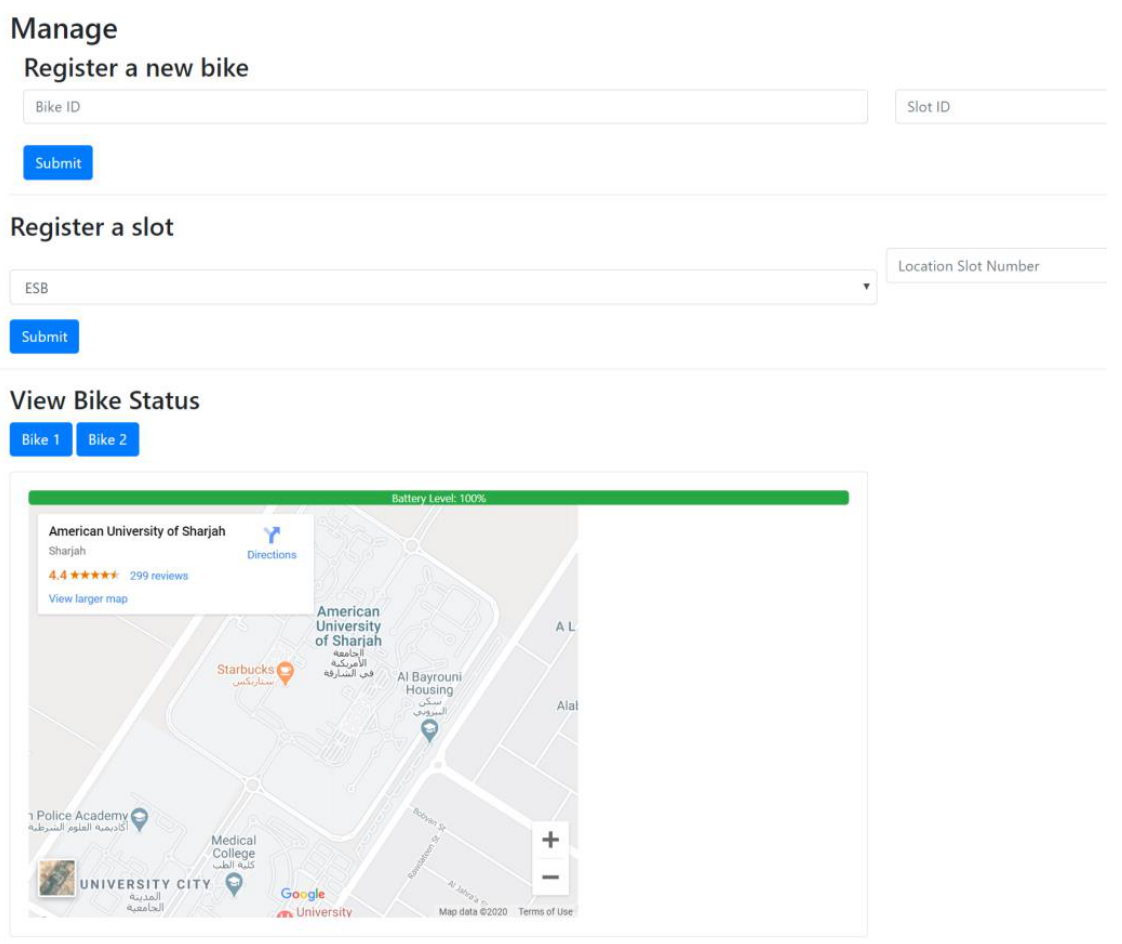
Figure 10. Manage view to register a new e-bike and view registered e-bike status.